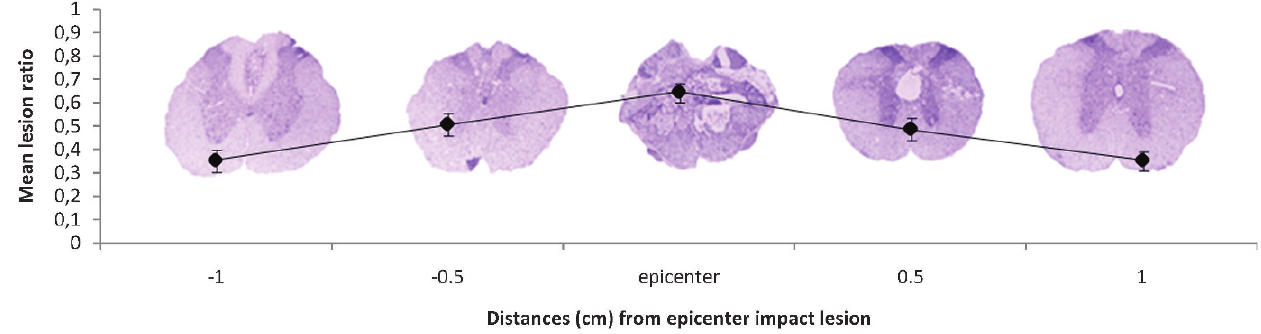
Figure 5 - Injured spinal cord transverse slices, 7 m m thick. The epicenter showed a significant difference compared to the